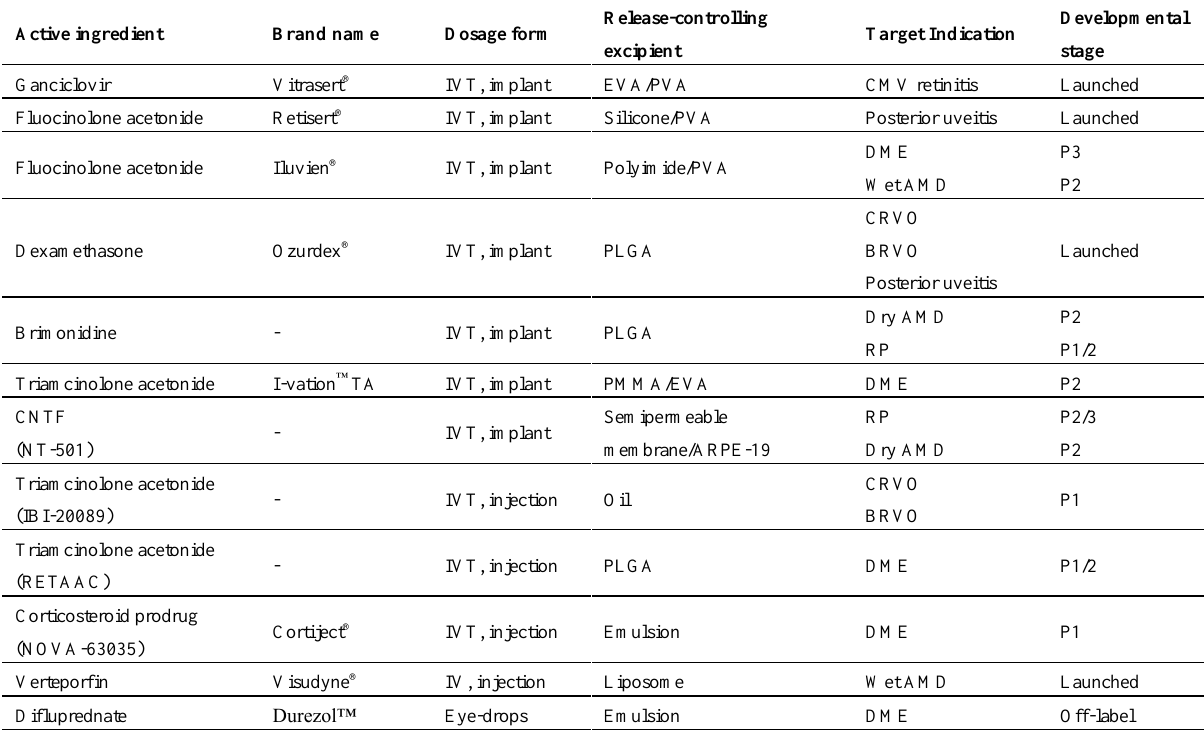
Table 2. Current and future drugs in clinical trials for posterior DDSs.